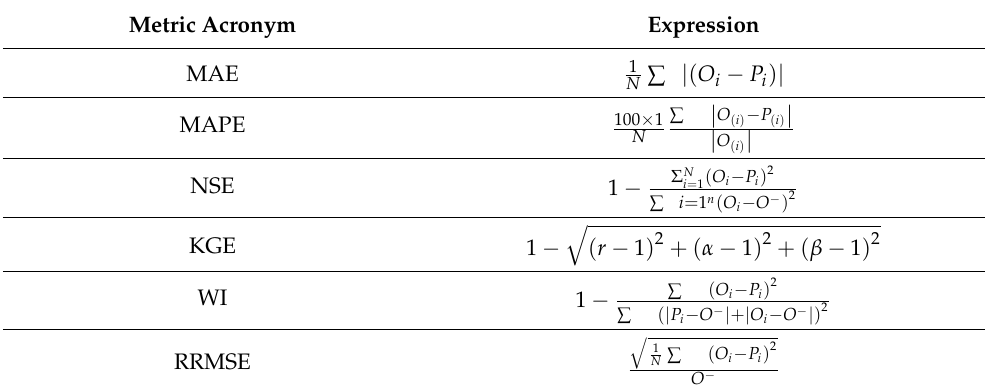
Table 6. Performance metrics used in the